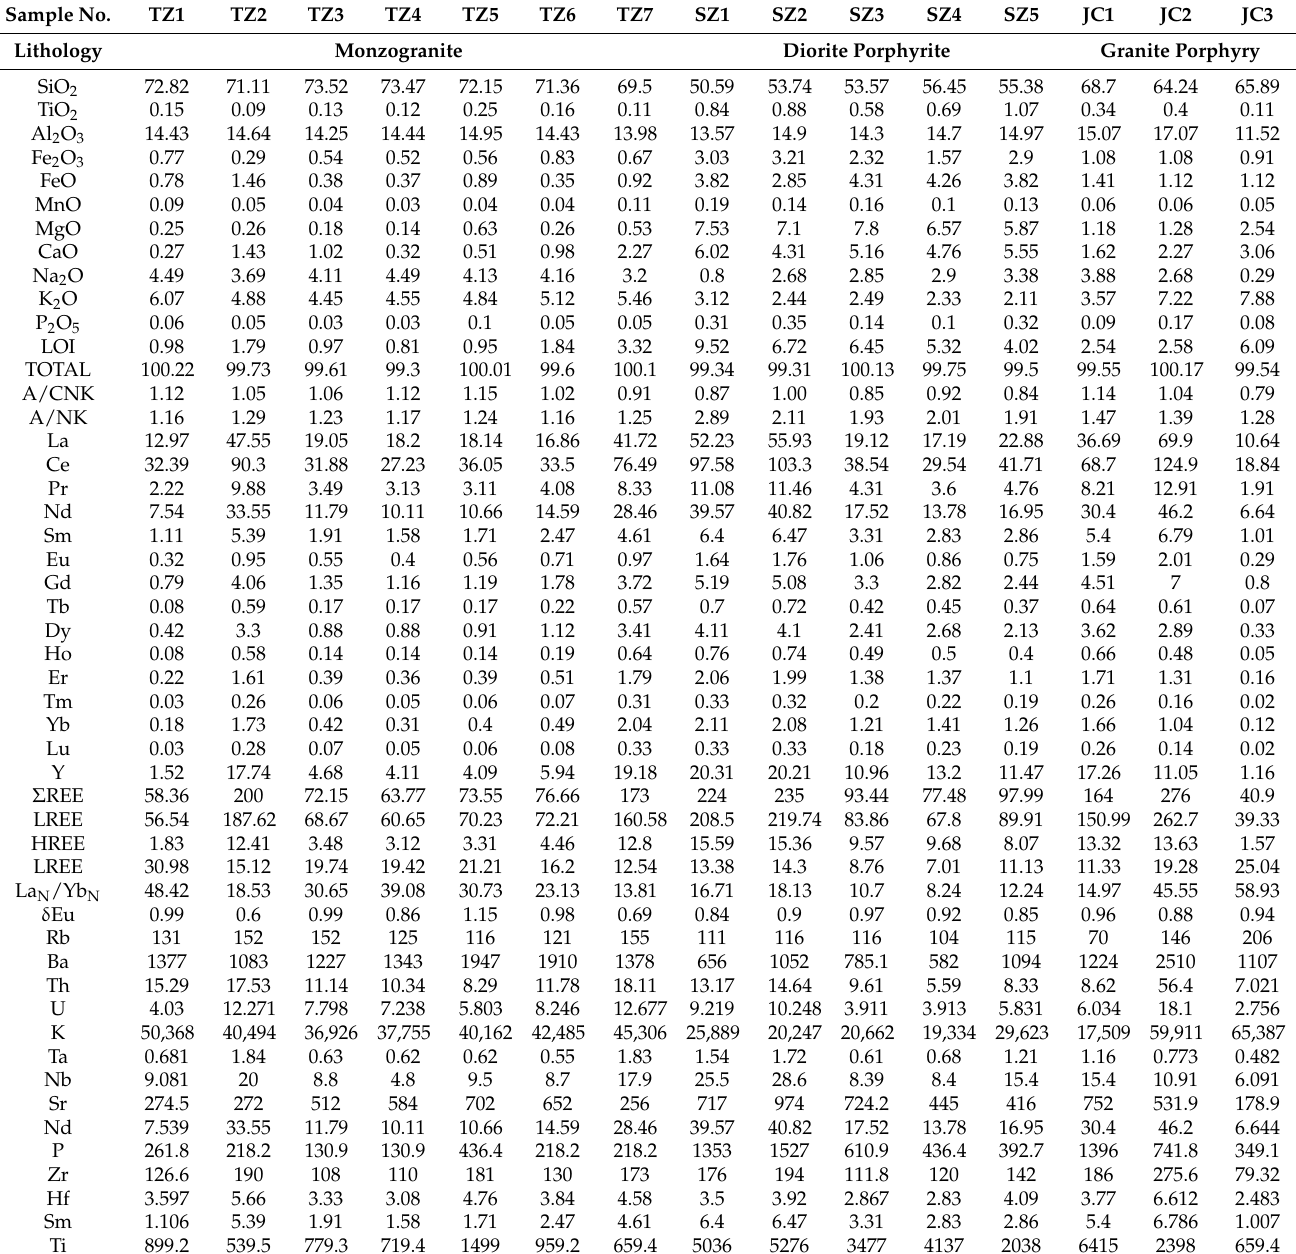
Table 1. Major element contents (wt %) trace and rare earth element concentrations (ppm)